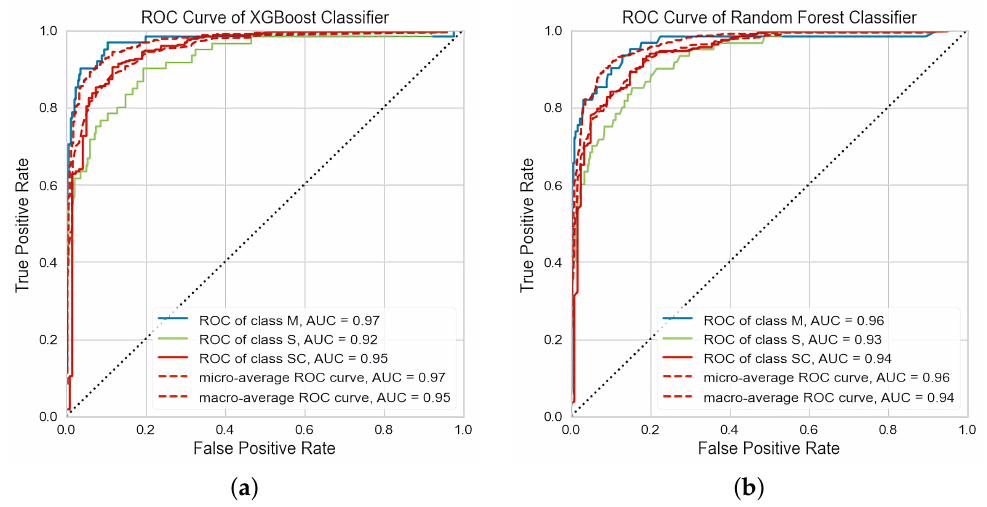
Figure 2. ROC Curve for XGBoost ( a ) and RF ( b ). M refers to mudstone, S refers to sandstone, and SC refers to sandy